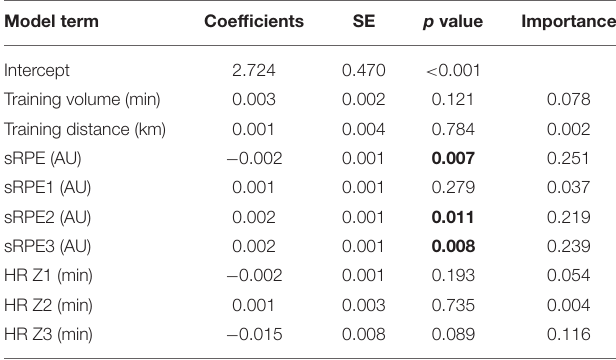
TABLE 2 | An automatic linear modeling to indicate the main predictors of Fatigue scale levels. Model